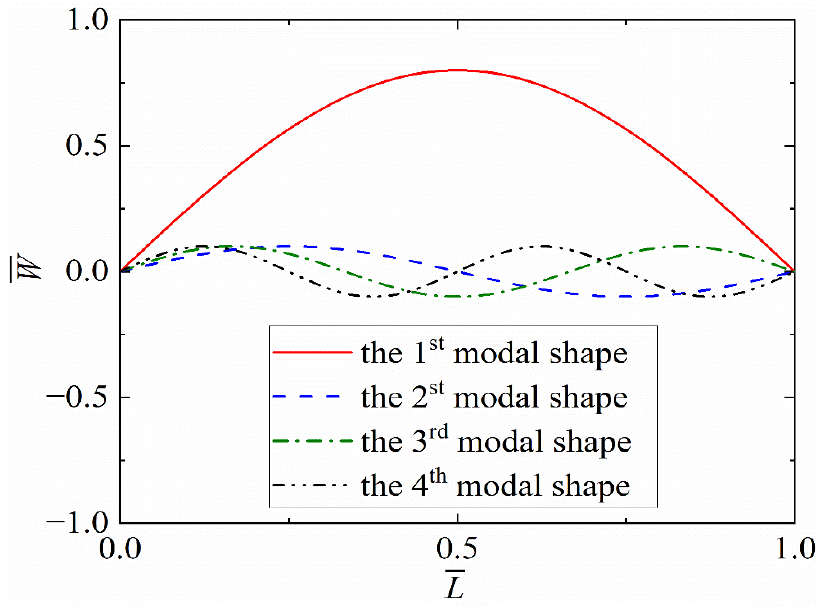
Figure 3. Schematic of the first four modal shapes.